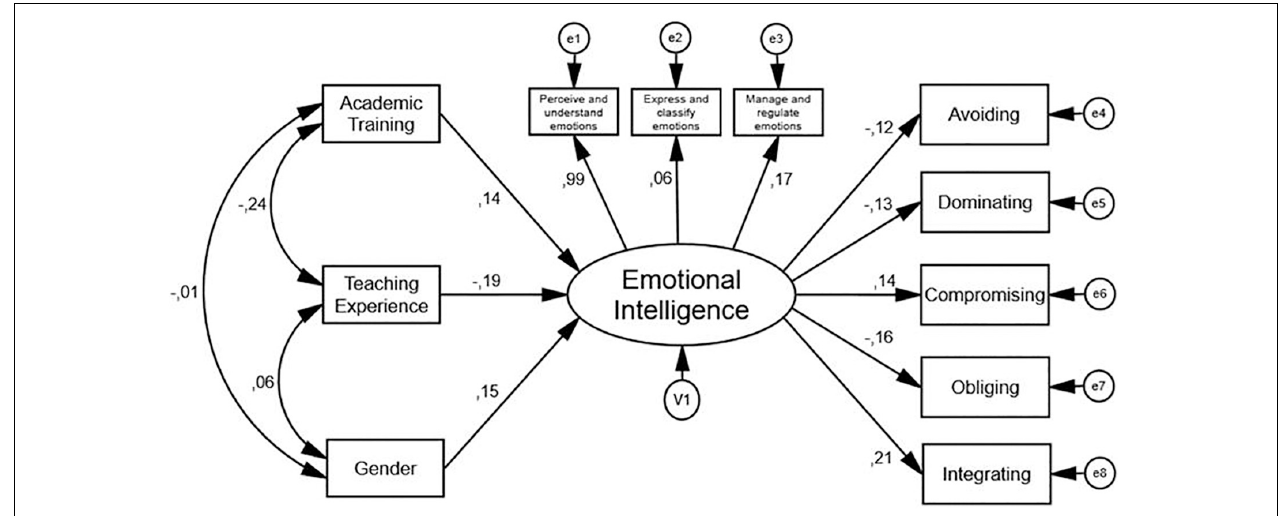
FIGURE 1 | Structural equation model results ( n = 382).